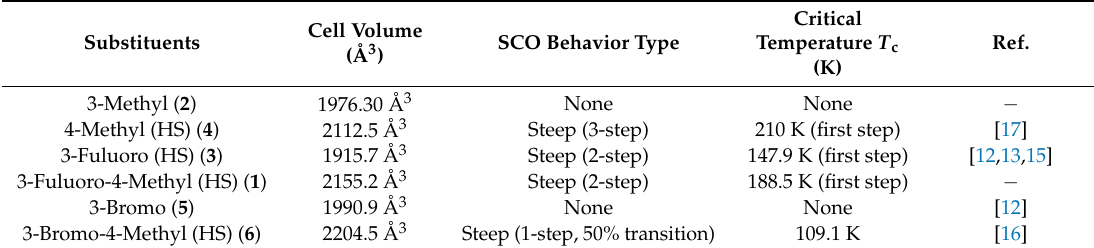
Spin crossover (SCO) behavior types, cell volumes, and critical temperatures of